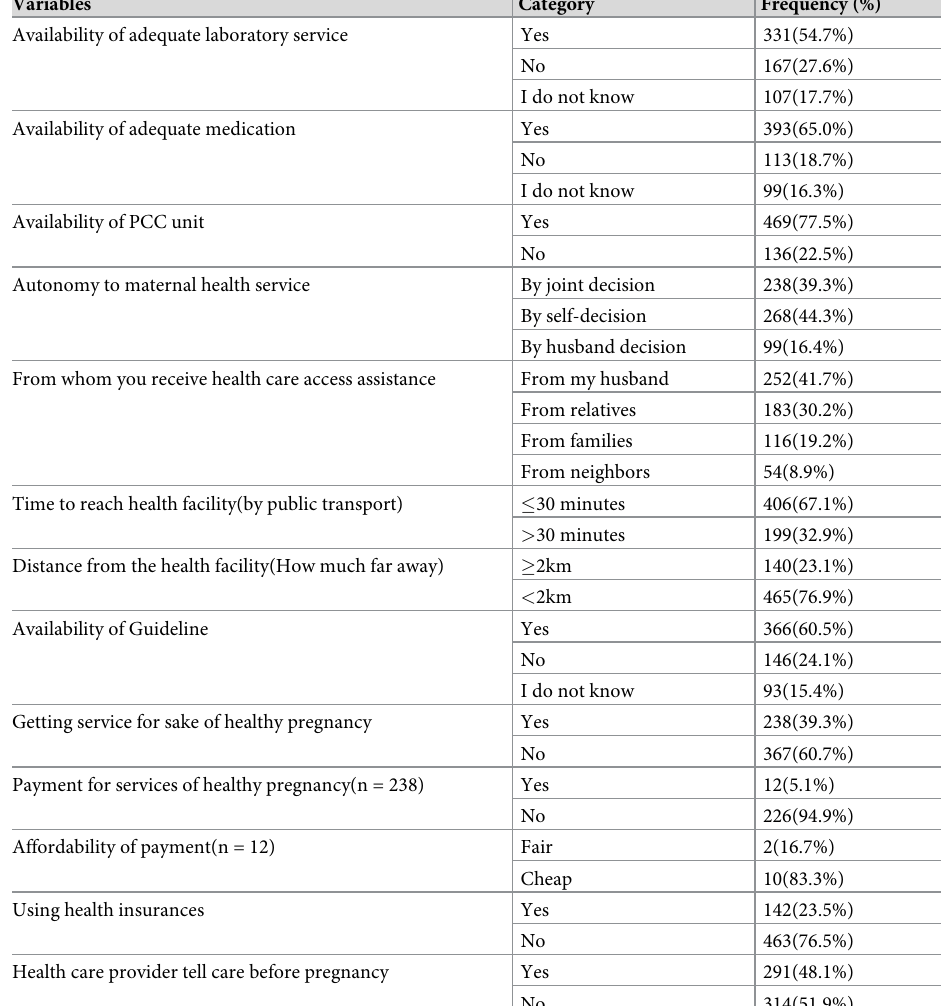
Table 3. Health services related characteristics of respondents in Mizan-Aman town, Southern Ethiopia, 2020 (n =